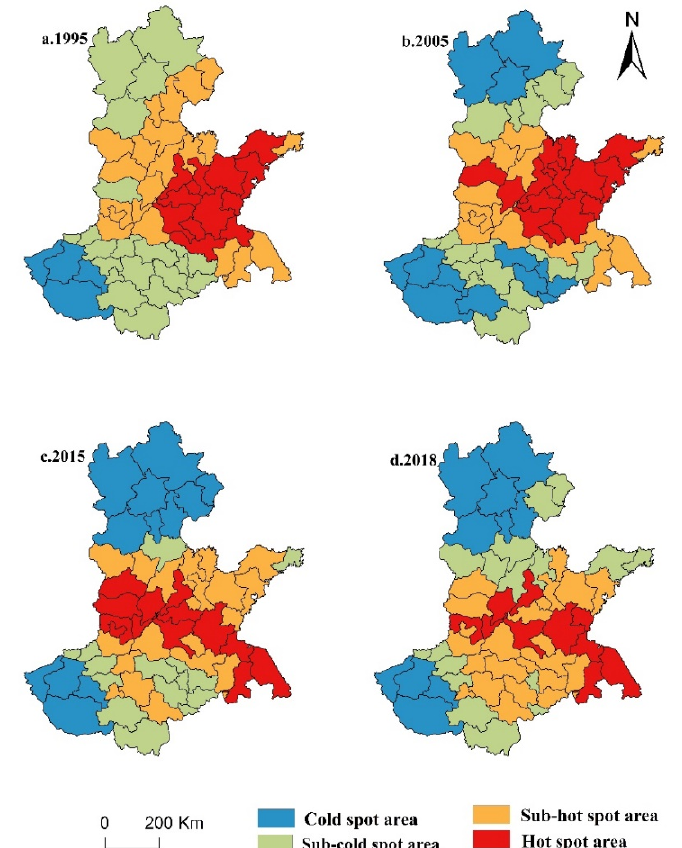
Figure 5. Spatial correlation characteristics of grain production in the HHH. ( a ) 1995, ( b ) 2005, ( c ) 2015, and ( d ) 2018 .